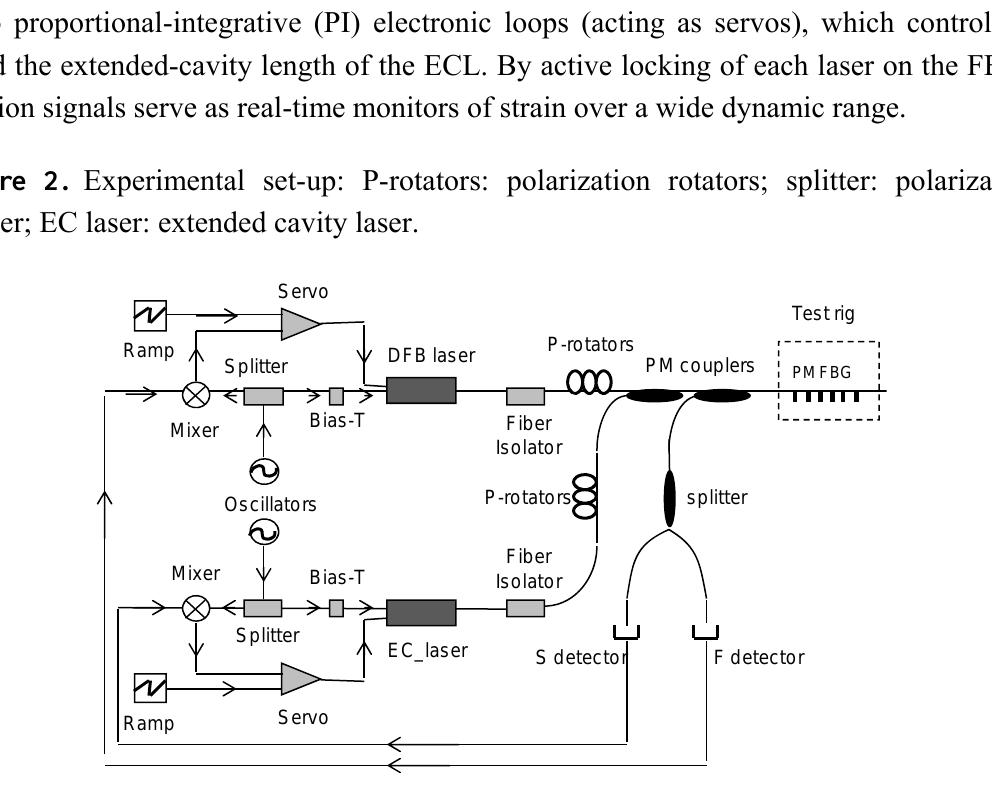
Figure 3. Mixer output line shapes over a laser-frequency scan around the PM Bragg resonances with a 45° linear polarization